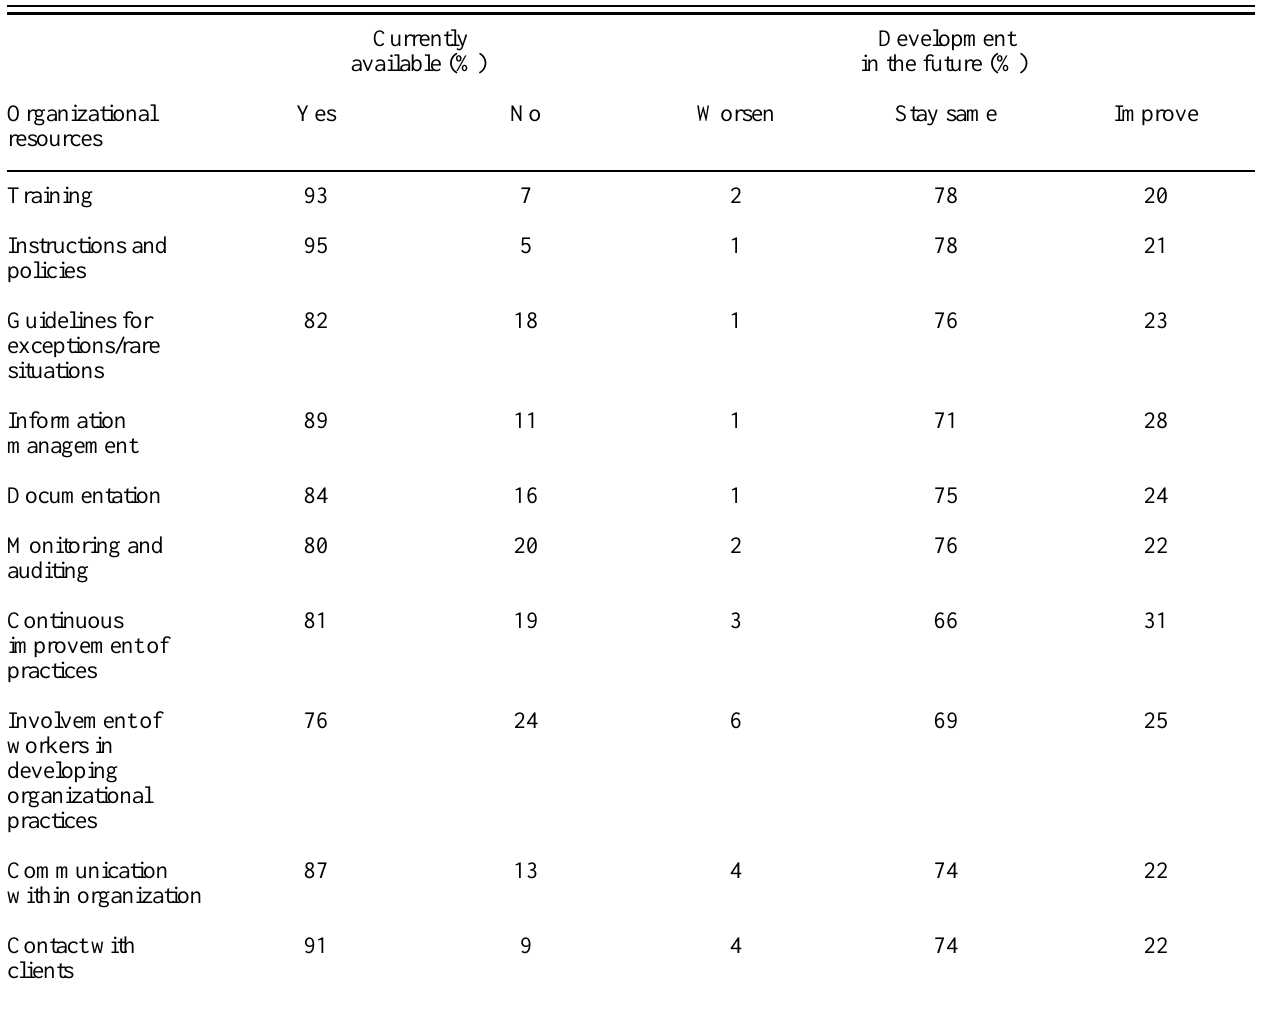
Table A3-2. Frequency of responses to organizational resource questions. Currently available